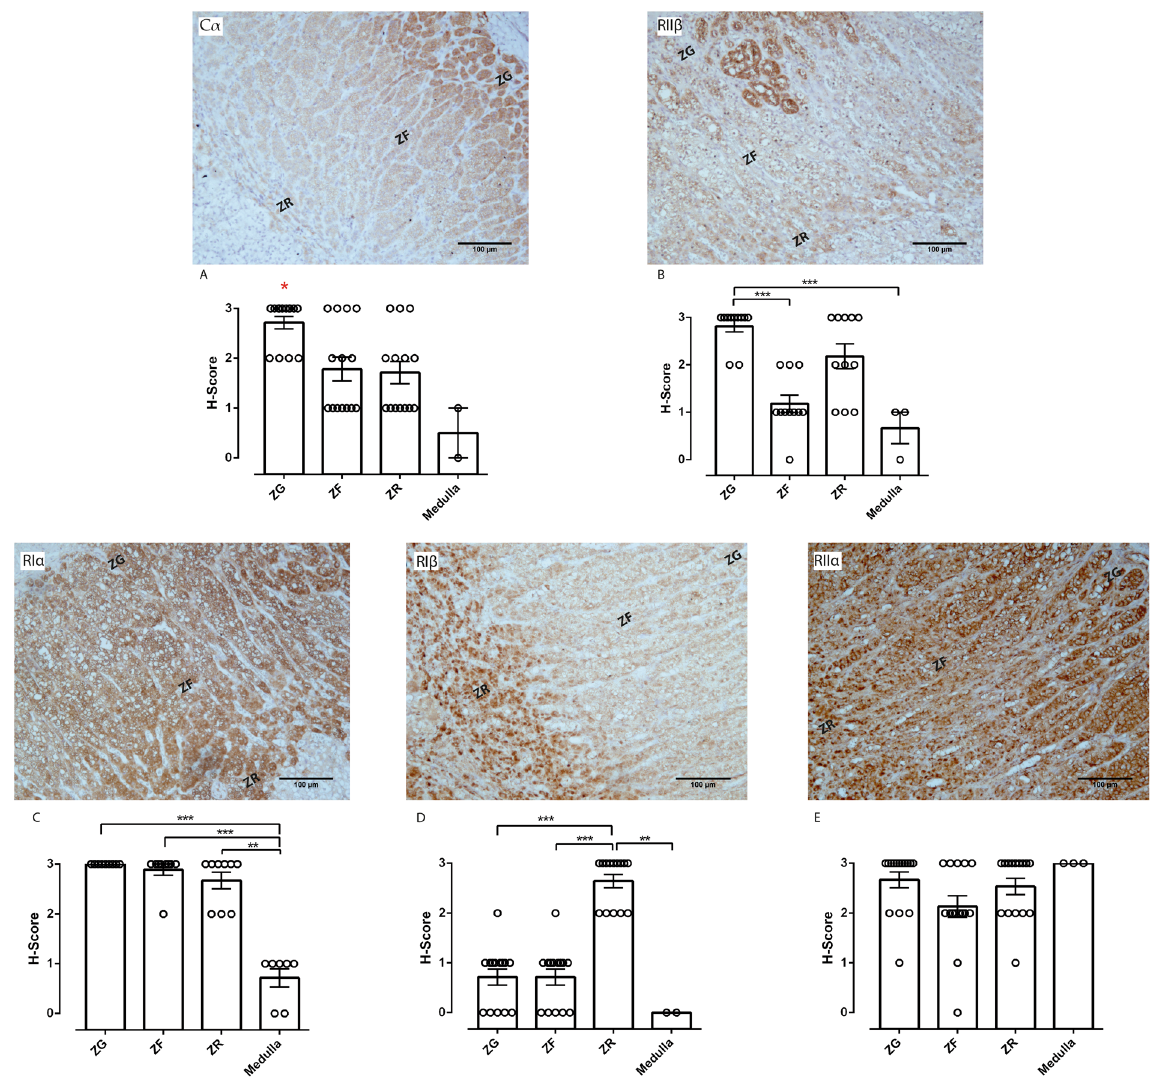
Figure 5. Immunohistochemical staining of the PKA subunits in normal adrenal glands. Representative immunohistochemical staining of the PKA subunits in the different zones of the adult normal adrenal gland and analysis of staining intensities of the different zones of the adrenal cortex and the medulla. C α is strongly expressed in the Zona glomerulosa ( A ), RII β is strongly expressed in the Zona glomerulosa and Zona reticularis ( B ), RI α is strongly expressed in all zones of the adrenal cortex ( C ), RI β has a strong expression in the Zona reticularis ( D ) and RII α is expressed in the whole adrenal gland including the medulla ( E ). ZG: Zona glomerulosa , ZF: Zona fasciculata , ZR: Zona reticularis . Kruskal-Wallis test with Dunn’s correction for multiple comparisons was performed to determine statistically significant differences between all data sets. * p < 0.05, ** p < 0.01, *** p <